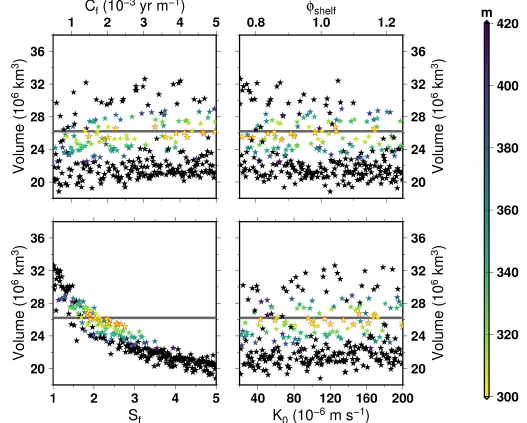
Figure 5. Simulated total ice volume for each ensemble members as a function of parameter values when using the Schoof (2007) formu- lation of the flux at the grounding line (AN40S). The thick horizon- tal line shows the observations (Fretwell et al., 2013). The colour shading corresponds to the root mean square error in ice thickness relative to observations. The stars outlined in red are the 12 ensem- ble members having the lowest RMSE.